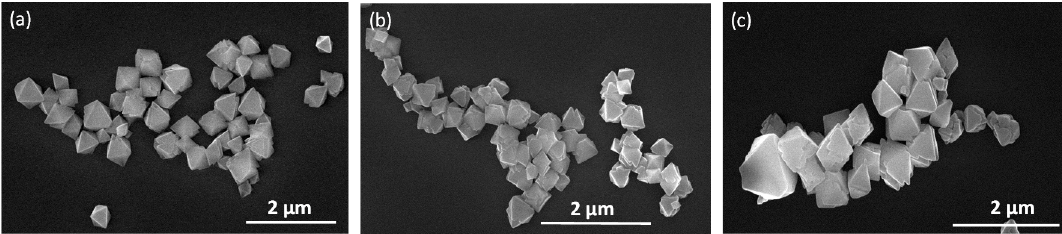
Figure 6. ( a ) FESEM images of sub-microparticles of compound 1n with an average size of 403 ± 130 nm obtained heating at 40 °C for 5 min and leaving the solution 20 h at 25 °C; ( b ) 1n sample stored for one week at 25 °C, with an average size of 467 ± 52 nm; and ( c ) 1n sample stored for one month at 25 °C with an average size of 484 ± 28 nm. The means and standard deviations were calculated from values corresponding to 60 particles from FESEM images.